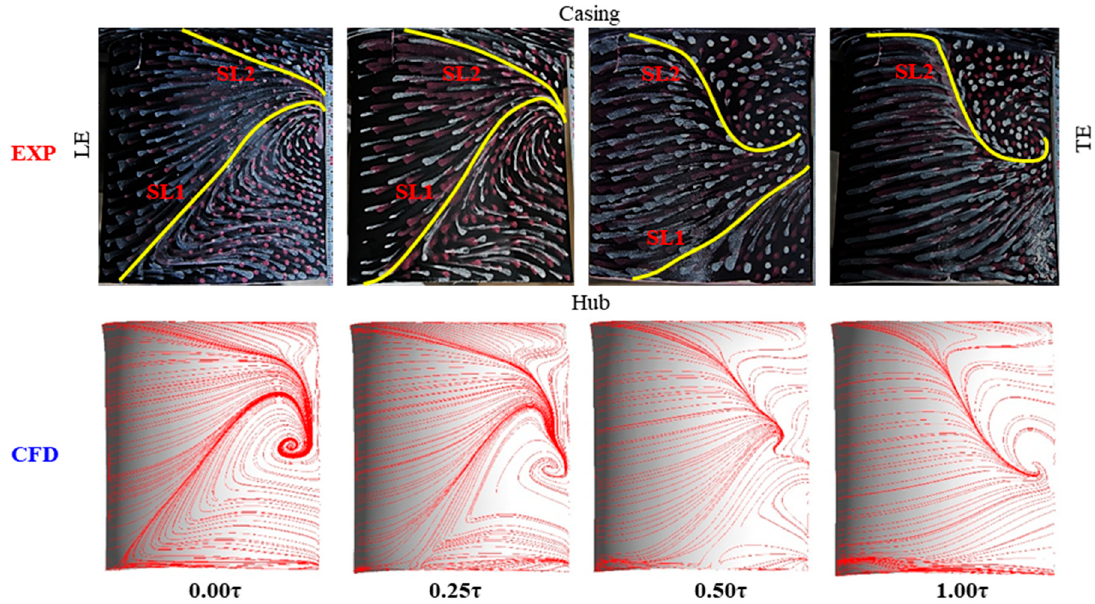
Figure 6. Limiting streamlines on the stator suction surface in the NS condition.